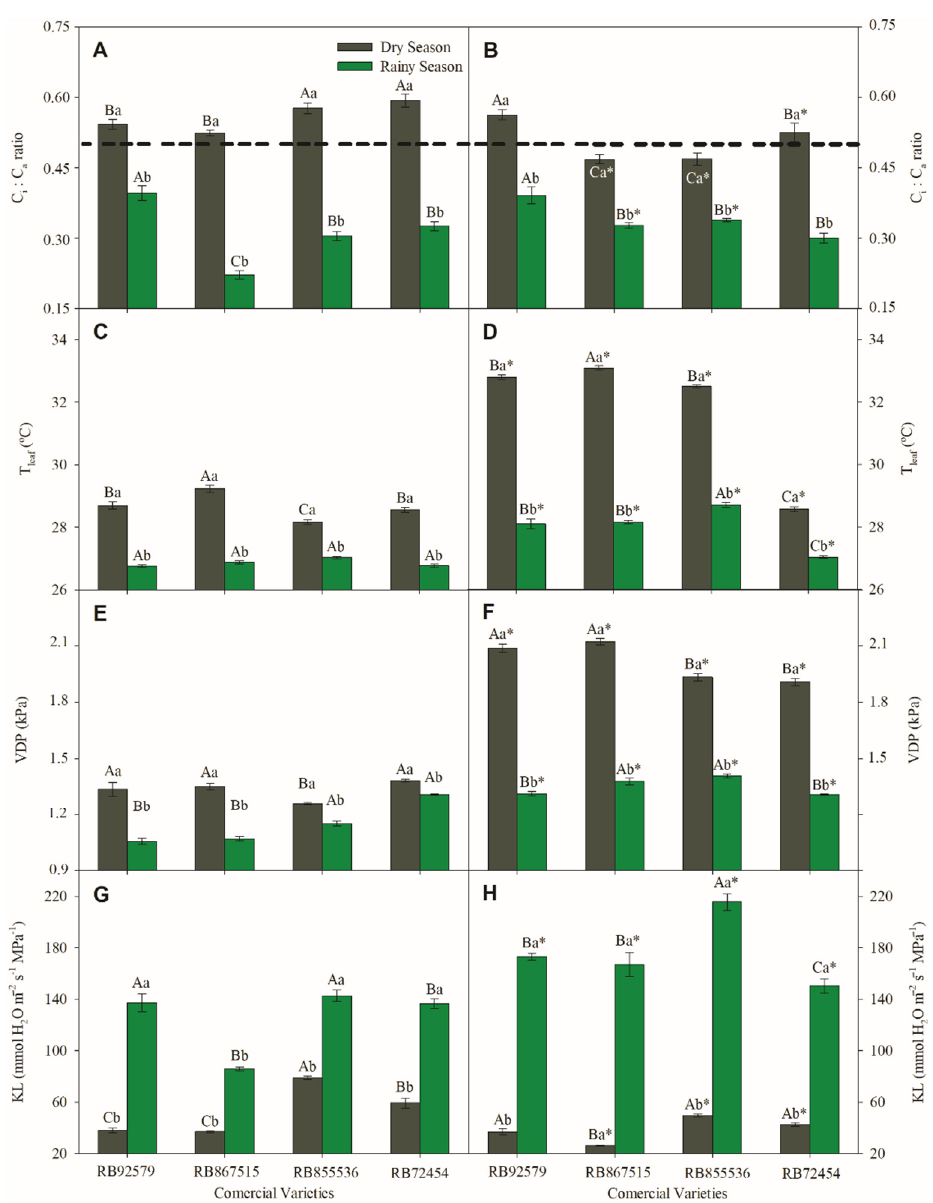
Figure 3. Internal-to-ambient CO 2 concentration ratio (C i :C a ratio, ( A , B )), leaf temperature (T leaf ; ( C , D )), vapor pressure deficit (VPD; ( E , F )), and leaf hydraulic conductance (KL; ( G , H )) measured in four varieties (RB92579, RB867515, RB855536, and RB72454) of sugarcane. The evaluations were made in dry season (gray bars) and rainy season (green bars) at 8:00 to 10:00 h ( A , C , E , G ) or at 12:00 to 13:00 h ( B , D , F , G ). Different lowercase letters denote significance within season for each variety, and different capital letters denote significance within varieties for the same season. An asterisk (*) denotes significance within 8:00 to 10:00 h and 12:00 to 13:00 h measurements in the same treatment. The doted line ( A , B ) denotes que arbitrary value proposed to determine the stomatal or non-stomatal restriction.